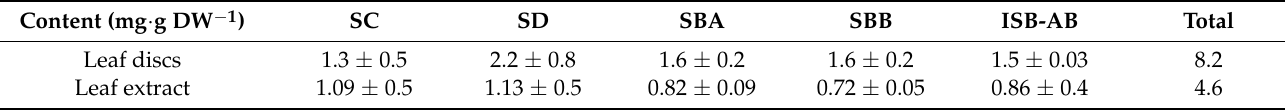
Table 1. Production of silymarin (mg · g callus DW − 1 ) from callus extract by using S. marianum leaf discs or leaf extract during incubation for 16 h and 3 h, respectively. Chromatograms obtained by HPLC separations for quantification of silymarin fractions, silychristin (SC), silydianin (SD), silybin A (SBA), silybin B (SBB), and isosilybin A and B (ISB-AB). The values are mean ± standard deviation (SD).